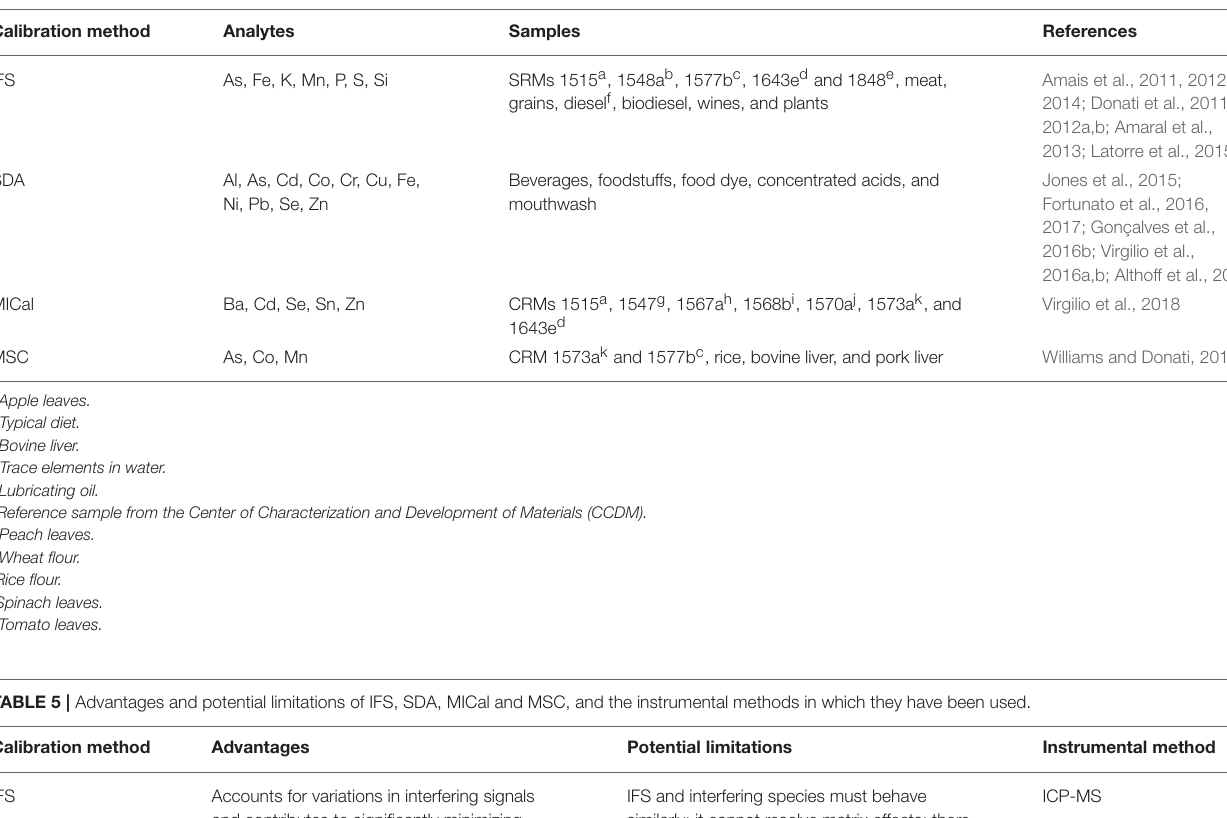
TABLE 4 | Applications of the non-traditional calibration methods and listed references.